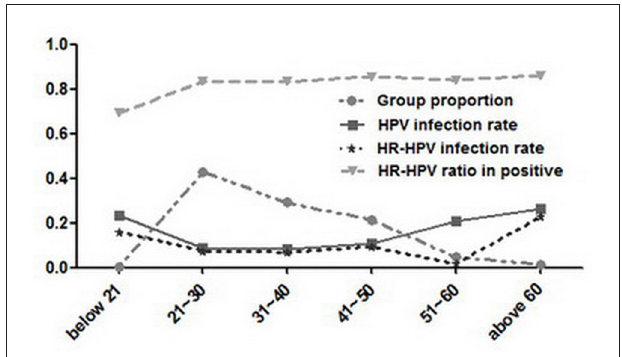
FIGURE 4 | HPV prevalence of different age groups among 12,053